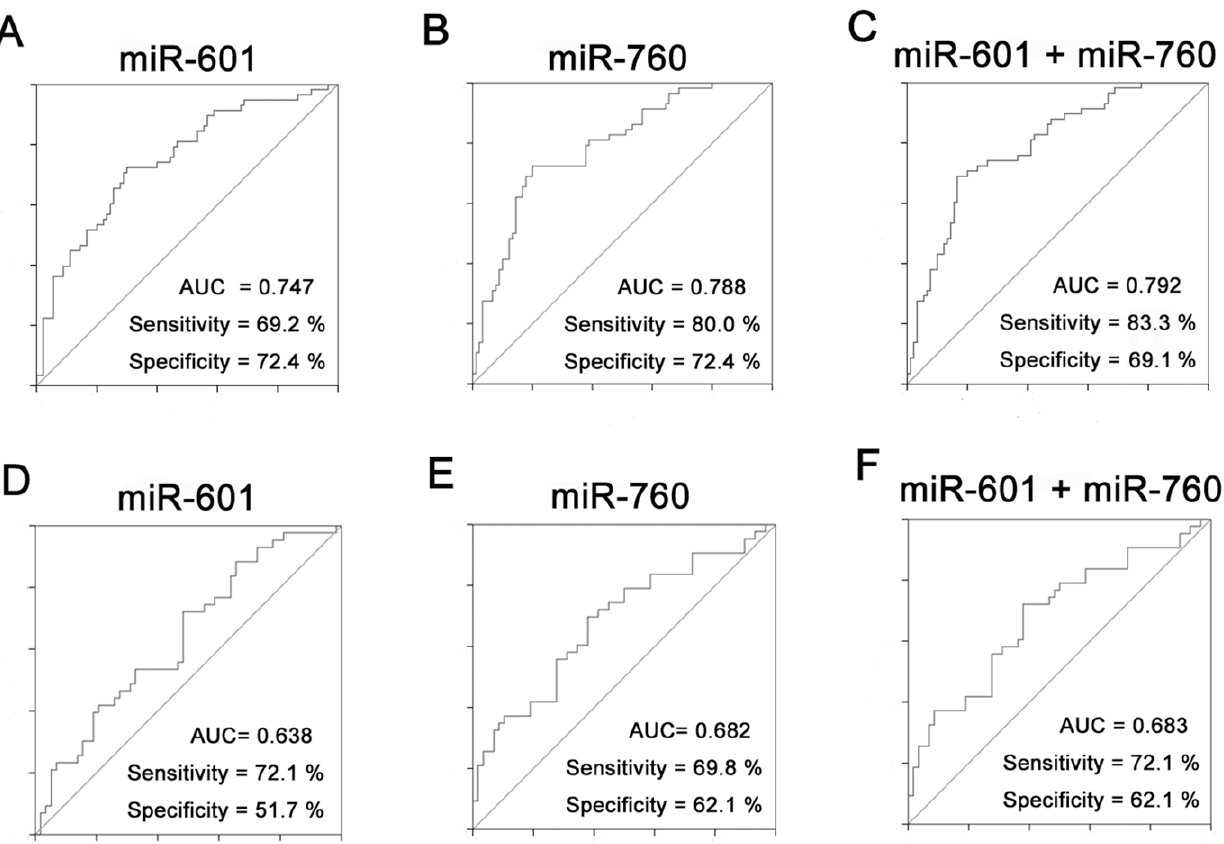
Figure 2. ROC curve analysis of plasma miR-601 and miR-760. (A, B, C) MiR-601 yield an AUC of 0.747(95% CI: 0.666–0.828) with 69.2% sensitivity and 72.4% specificity(cut-off value= 2 11.50), and miR-760 yield an AUC of 0.788(95% CI: 0.714–0.862) with 80.0% sensitivity and 72.4% specificity(cut-off value= 2 8.09) for discriminating CRC from normal controls. Combined analysis of miR-601 and miR-760 revealed an AUC of 0.792(95% CI: 0.719–0.865), with 83.3% sensitivity and 69.1% specificity. (D, E, F) MiR-601 yielded an AUC of 0.638(95% CI: 0.530–0.747) with 72.1% sensitivity and 51.7% specificity(cut-off value= 2 10.73), and miR-760 revealed an AUC of 0.682(95% CI: 0.576–0.789) with 69.8% sensitivity and 62.1% specificity(cut-off value= 2 7.63) for discriminating advanced adenomas from controls. Combined analysis of miR-601 and miR-760 did not improve the diagnostic efficiency, and gave a similar AUC of 0.683(95% CI: 0.576–0.789) with 72.1% sensitivity and 62.1% specificity as miR-760.